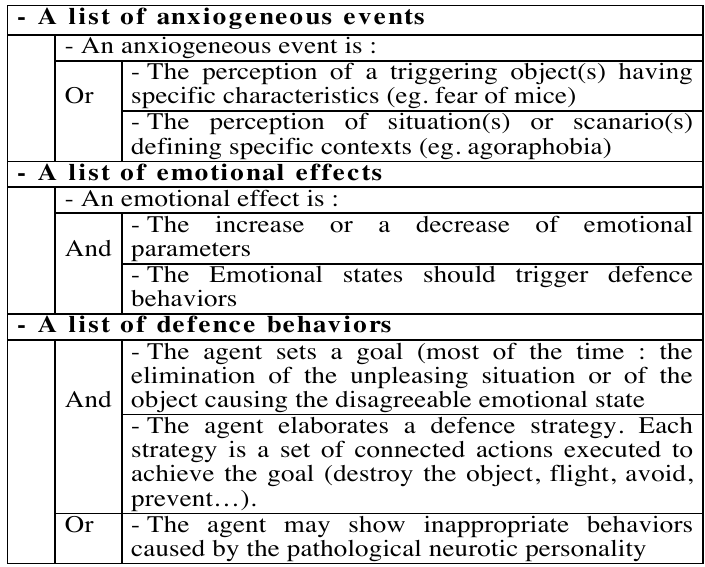
Fig. 1 A multilayer model of decision